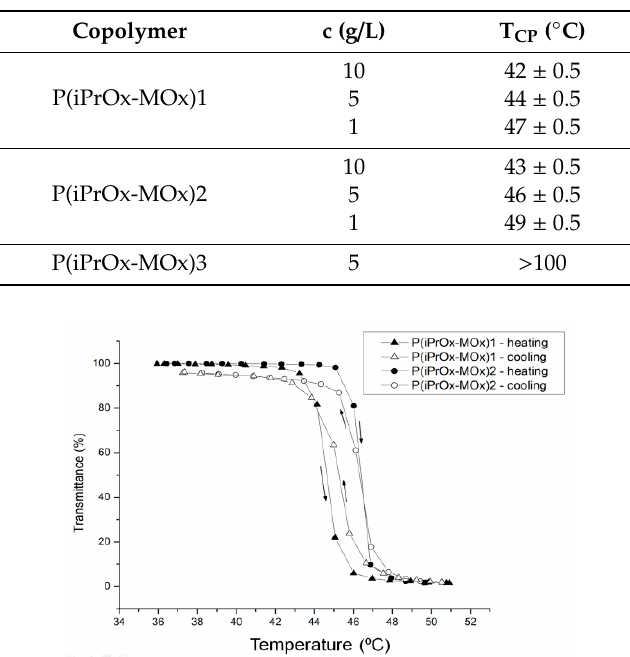
Table 2. T CP values of copolymers at di ff erent concentrations in water. Figure 2. ( a ) DSC traces (heating rate of 10 °C/min) and ( b ) X-ray diffraction curves for iPrOx/MOx copolymers annealed at 150 °C for 1 h.